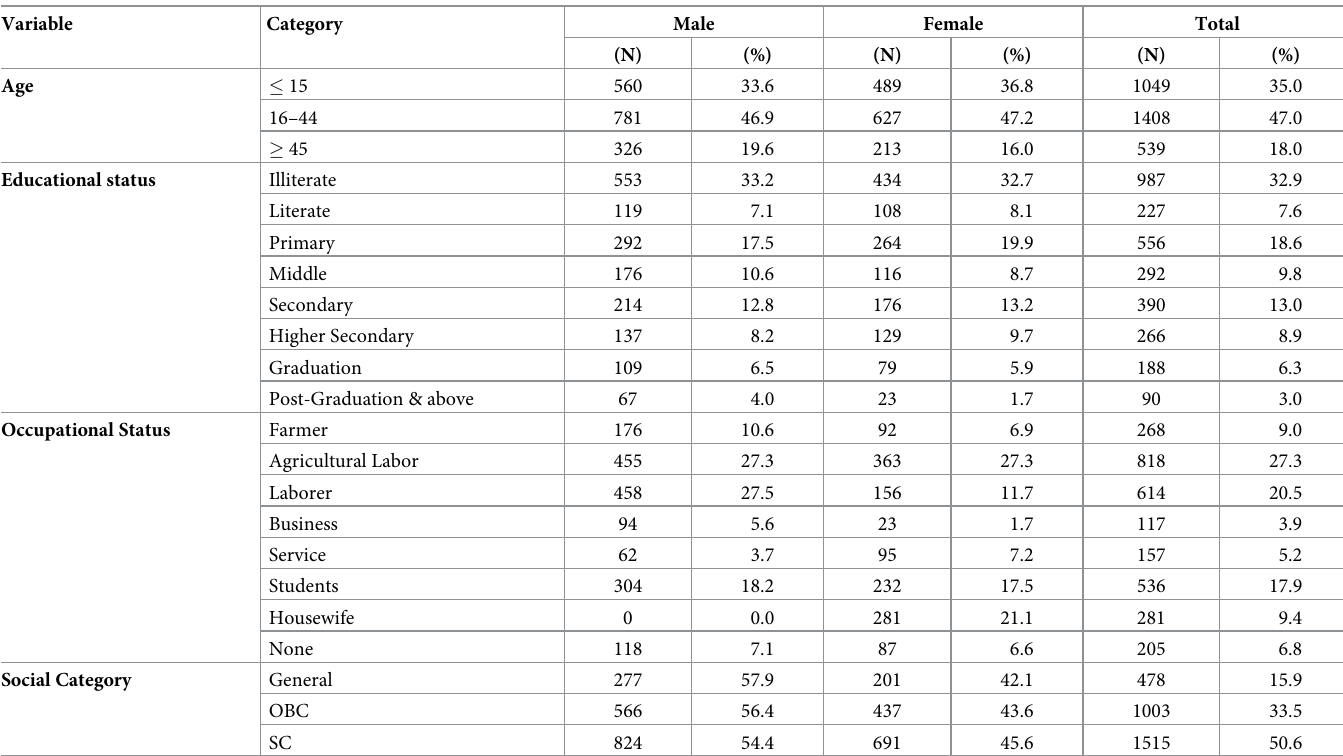
Table 2. Demographic characteristics of kala-azar cases by sites (N = 2996, Male = 1667; Female =